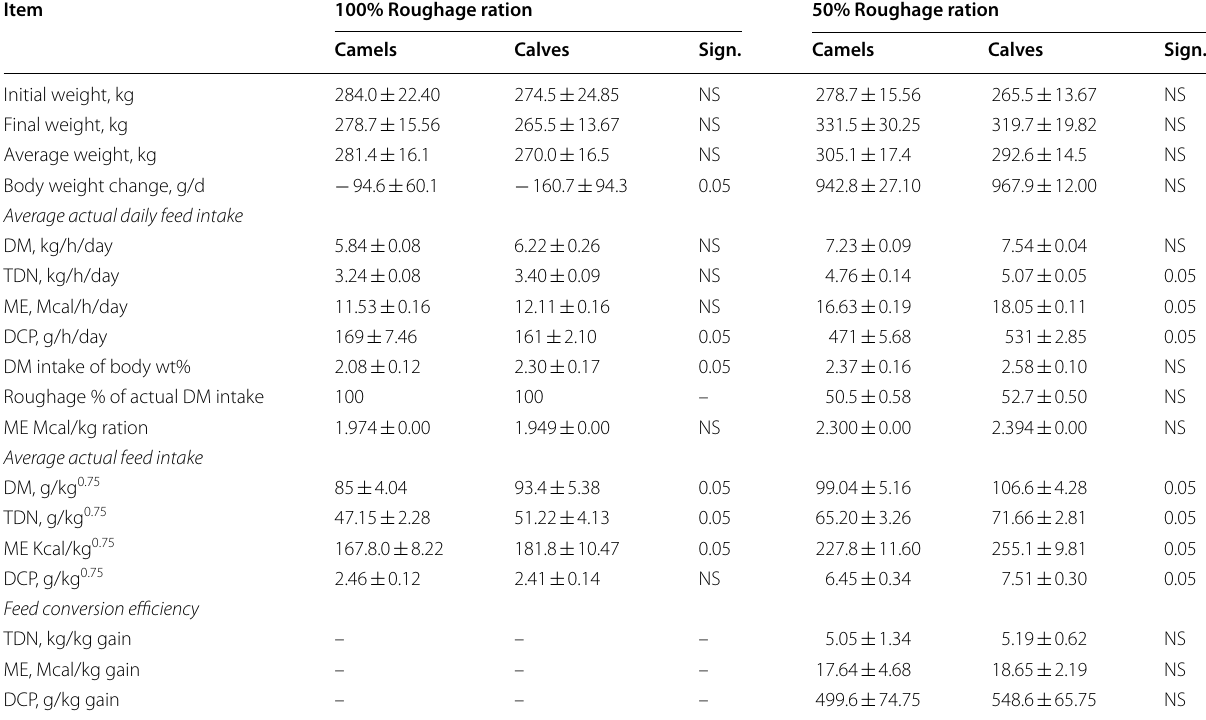
calves fed the two experimental rations are given in With feeding 100% roughage ration, camels had higher ( P < 0.05) total protein, albumin and globulin concentra- tions than calves, while corresponding concentrations were of comparable values in both species with feeding camels than calves under the two feeding regimes. Cre- atinine concentration was almost similar in camels and calves fed either 100% or 50%R ration; however, it was decreased with feeding the high protein ration (50% R) in both species. It is interesting to note that blood cho- lesterol and triglycerides were obviously lower ( P <